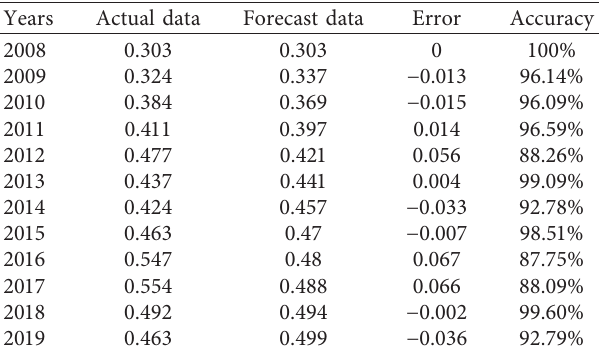
Table 3: The prediction and fitting data of the Grey Verhulst model.